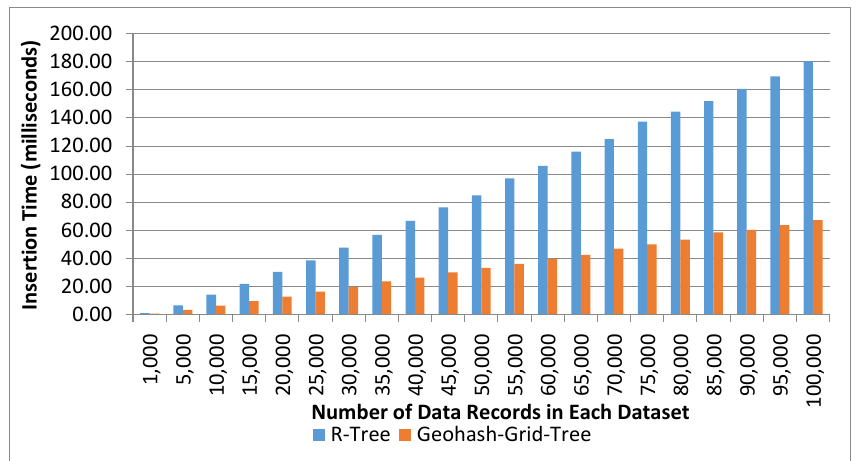
Figure 5. Index creation time: Geohash-Grid Tree and R-Tree.